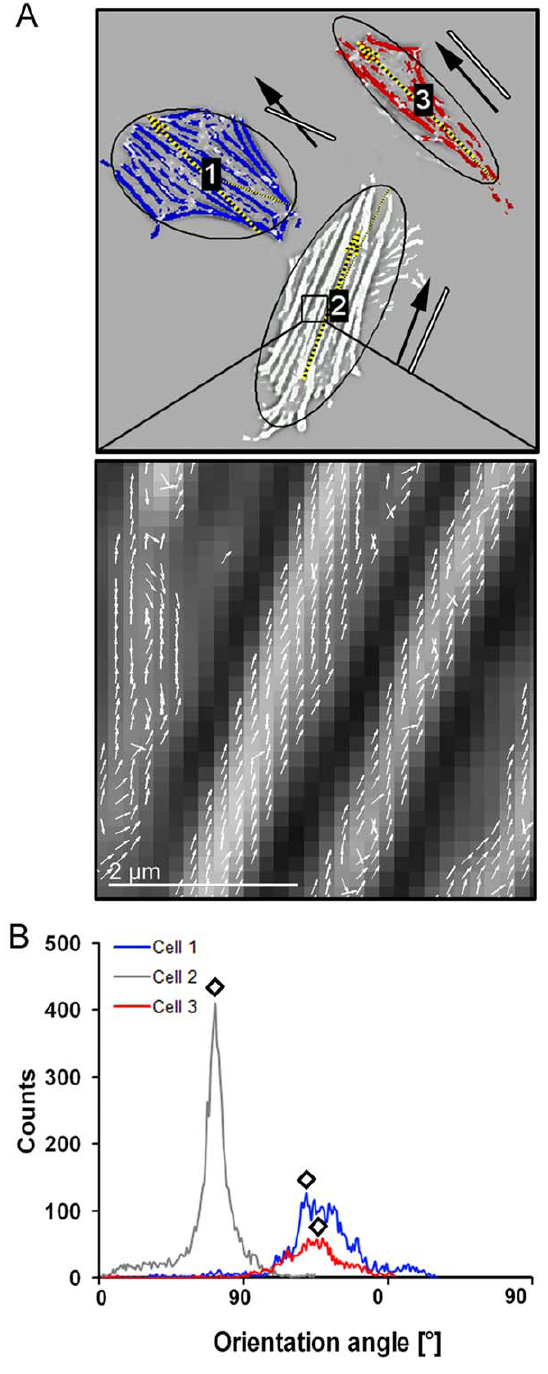
Figure 3. Determination of cell shape and cytoskeletal orientation. (A) Cells were stained for actin after stretch application and cell fixation. Every cell and its actin bundles were recognized by image processing. Actin bundle directions were determined at every single pixel as perpendicular direction to the grey value gradient (inlay). The major axis of the ellipse with the same normalized second central moments as the cell characterized the main cell orientation. Black arrows next to the cells indicate main actin orientation, and the white lines give the cell shape orientation. (B) Histogram of measured actin orientations of the cells 1 to 3 given in A. All values of each cell were used to determine the main actin orientation angle indicated for the three cells (diamonds). See also Table 3 or Figure 4.